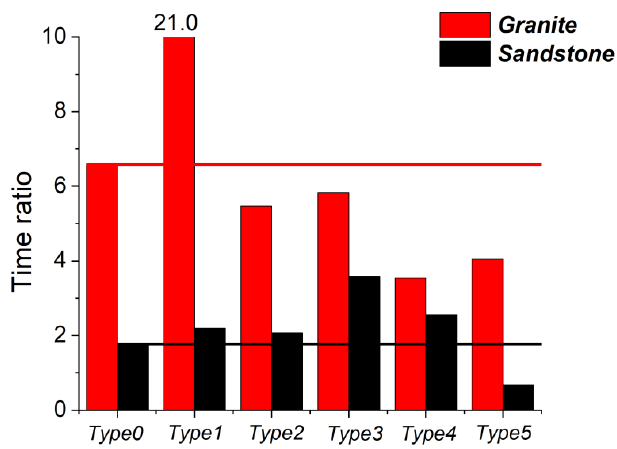
Figure 11. The time ratio index of